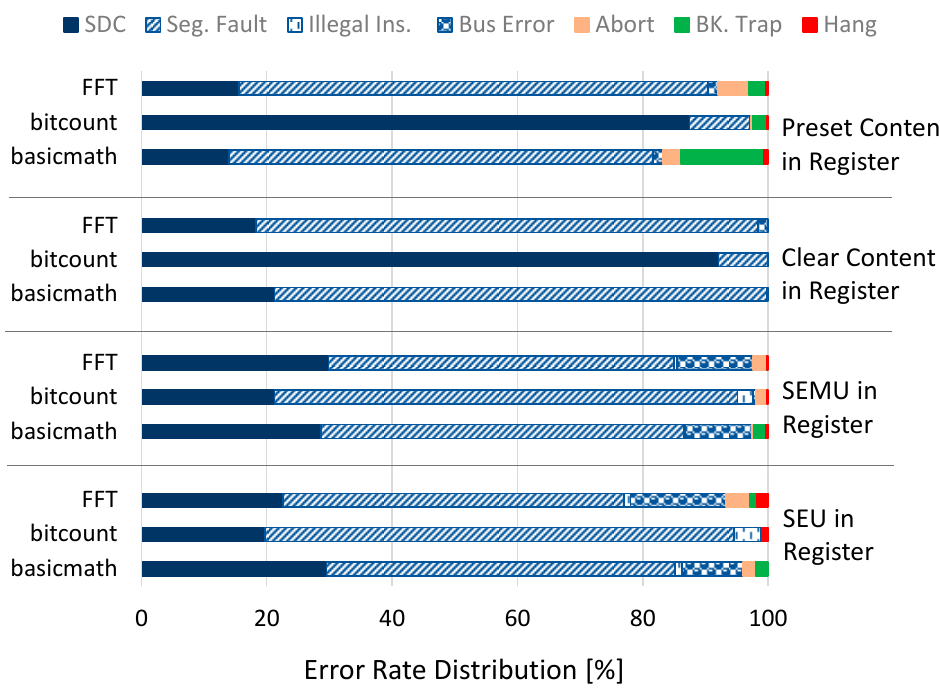
Figure 9. The error rate distribution for the SEE fault injection campaigns in registers. Table 1. Error rate classified per application and fault model in memory.